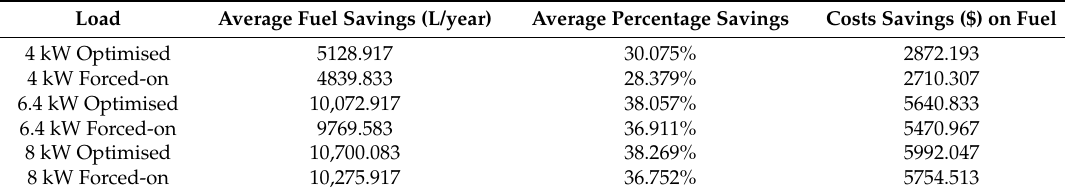
Table 12. Summary of average